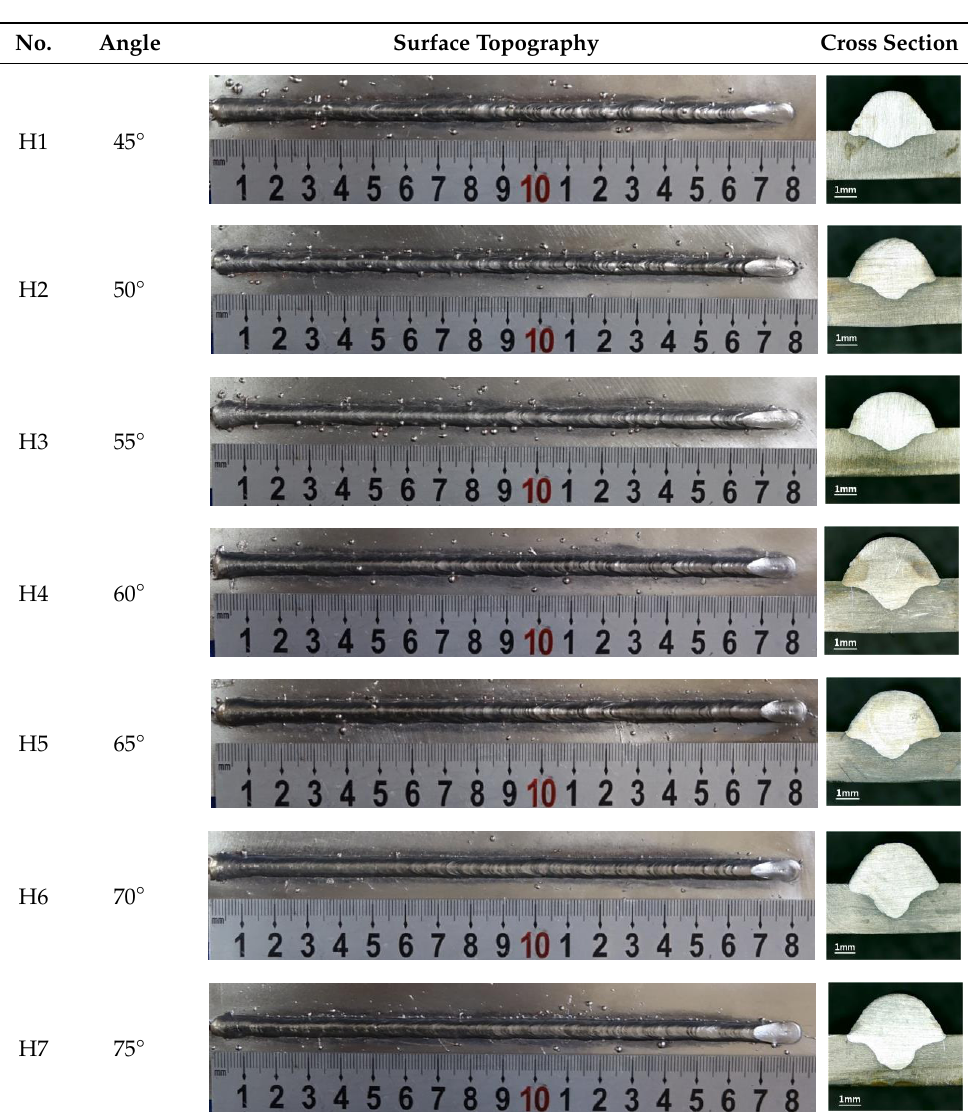
Table 4. The surfaces and cross sections of the weld bead under backward inclination mode. Angle Surface Topography